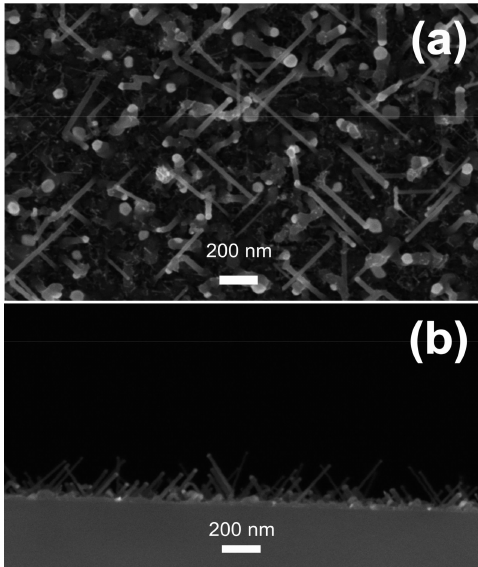
Figure 1. Scanning electron microscope (SEM) micrographs in planar ( a ) and cross-sectional view ( b ) of silicon nanowires (Si-NWs) array grown on Si (100) substrate, prepared by Au-catalyzed VLS growth in plasma